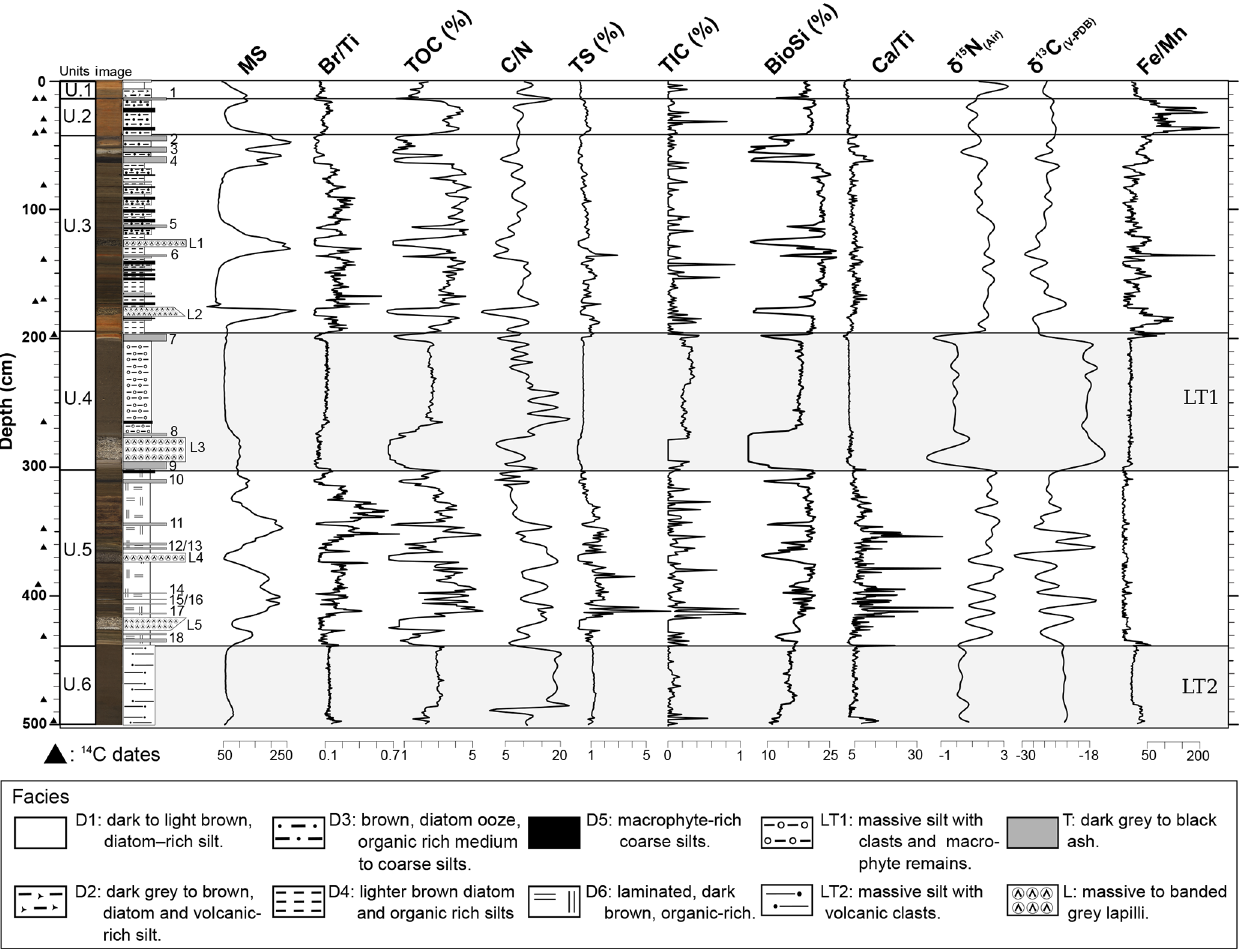
Figure 4. Sedimentary facies and sedimentological units in the LdM sequence for site 3. Six lithostratigraphic units (U) and three main facies groups: lacustrine facies (D1 to D6); lacustrine turbidites (LT1 and LT2); and volcanic facies (lapilli L1 to L5 and tephras T1 to T18). The lacustrine facies have been classified according to elemental composition: magnetic susceptibility (MS; × 10 − 8(m 3 kg − 1 )), percentage of the total organic carbon (TOC), total sulfur (TS), total inorganic carbon (TIC), biogenic silica (BioSi), atomic TOC / TN values, δ 15 N and δ 13 C values in per mill (standardized with N2-Air and Vienna Pee Dee Belemnite (VPDB), respectively), and XRF ratios as proxies for redox conditions (Fe / Mn) and organic (Br / Ti)